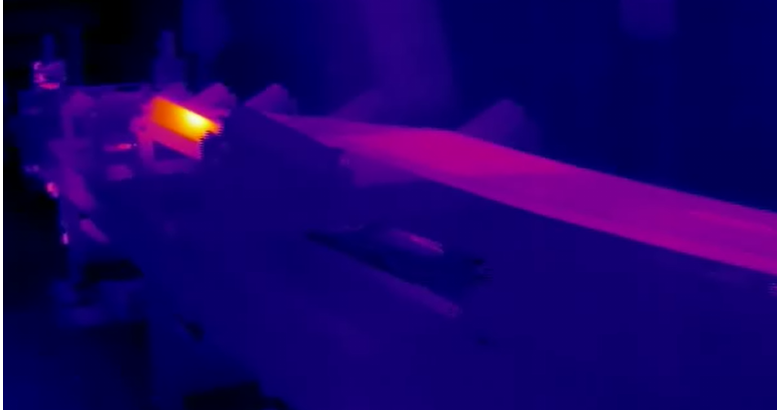
Figure 19. An infrared thermography image with one of idler with significantly higher temperature.